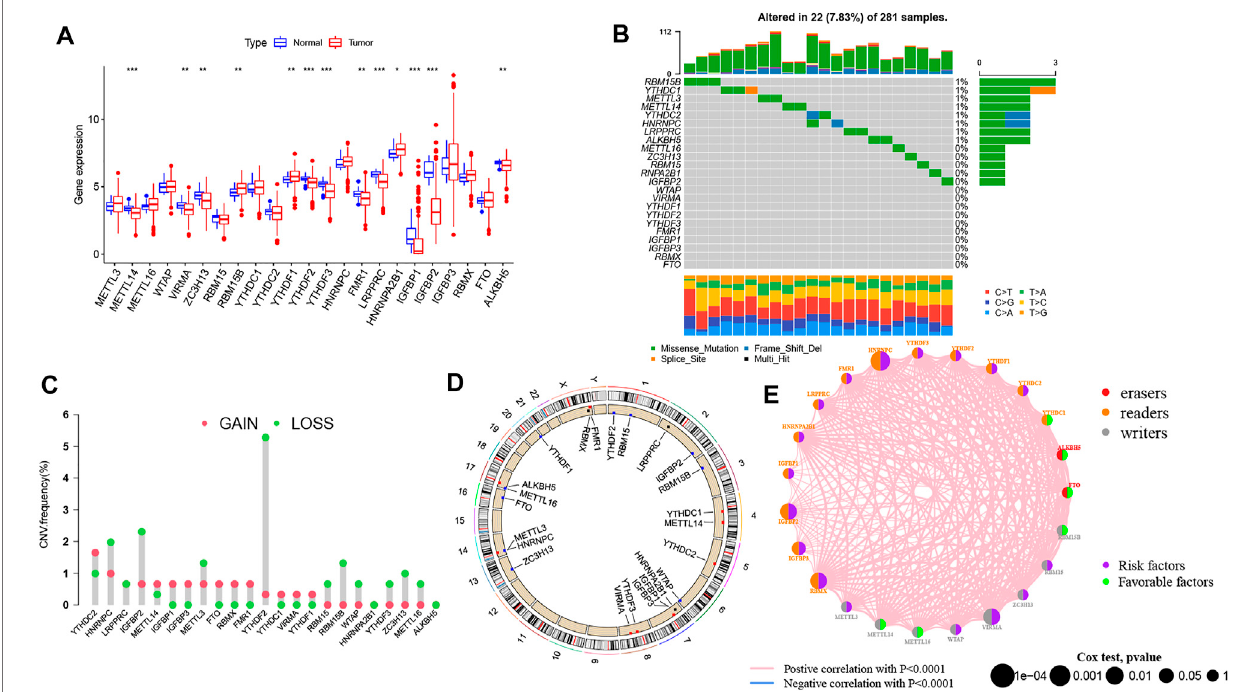
FIGURE 1 | Characteristics of genetic and variation of m 6 A genes in pRCC. (A) Transcriptomic pro fi le of 23 m6A genes among normal and PRCC tumor tissues. Theupperandlowerendsoftheboxesindicateinterquartilerange(IQR) ofvalues.Thelinesintheboxesrepresent eachthemedianvalue.Theasterisksrepresented the p value. (* p < .05; ** p < .01; *** p < .001) (B) Mutation frequency of 23 m 6 A genes in in 289 PRCC patients. The bar plot at the upper part of the fi gure shows TMB. Numbersontherightpartofthe fi gurerepresentthemutationfrequency. (C) CNValterationfrequencyof23m 6 Agenesinthe289-patientPRCCcohort.Theheight of each column indicates the alteration frequency. The red dot represents the ampli fi cation frequency; the green dot represents the deletion frequency. (D) Location of CNV alterations of 23 m 6 A genes on human chromosomes in PRCC cohort. (E) Interaction network of 23 m 6 A genes in the PRCC cohort. The size of each circle is indicative of the magnitude of the effect on the prognosis. The green dots mean the protective factors, and the purple dots represent the risk factors. The thickness of each line indicates the degree of correlation between each gene.